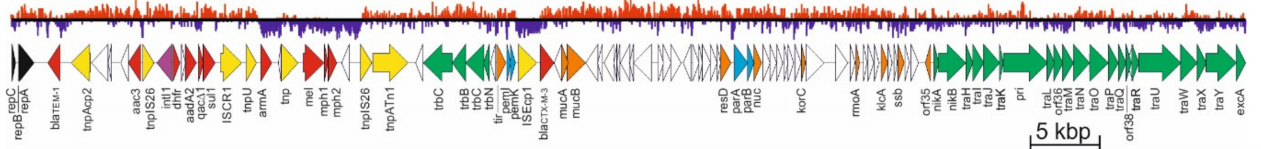
Figure 1. Schematic representation of pCTX-M3 sequence. Open reading frames (ORFs) are represented by arrows indicating their orientation. Genes encoding the replicon are in black, post-segregational killing and partition systems in blue, and conjugative transfer in green. Drug resistance genes are in red, transposase genes in yellow, other genes with homologues in databases in orange, and those of known functions are subscribed. A G+C plot is presented at the top; values higher than the average are in red and lower in